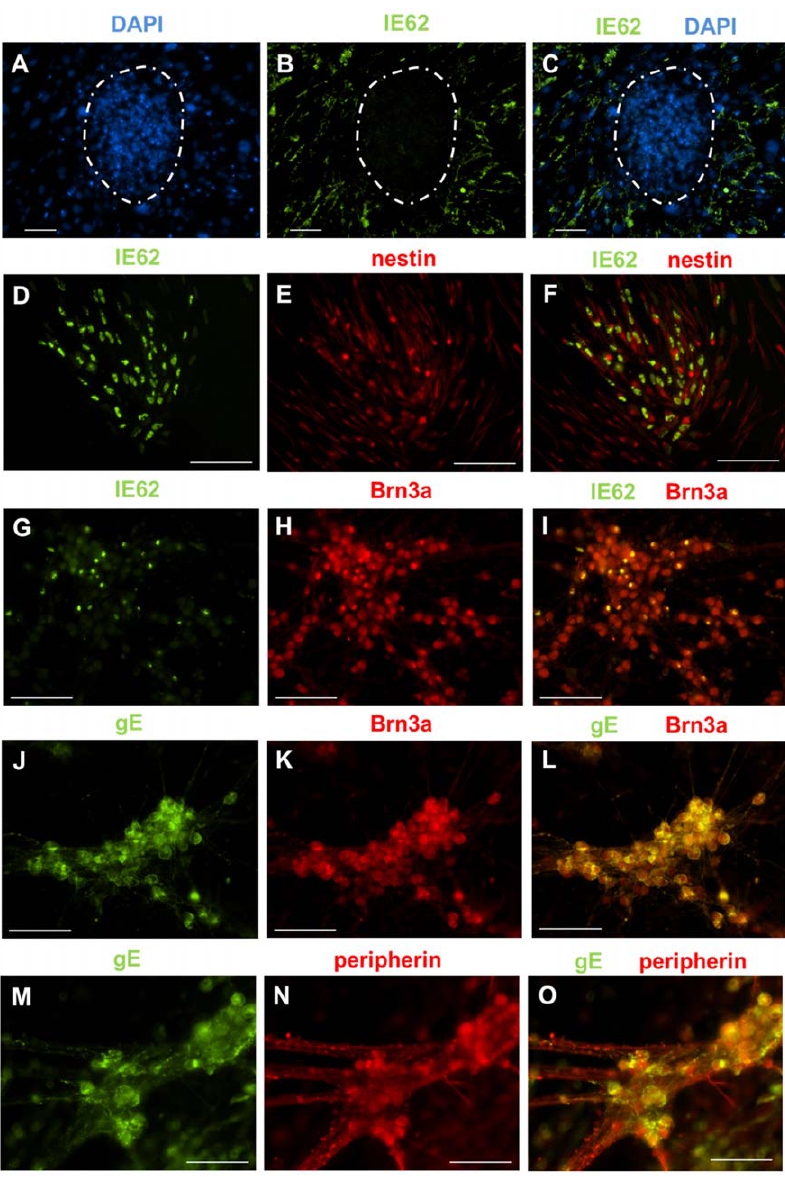
Figure 5. VZV infects iPS cell-derived neural progenitor cells and sensory neurons, but not undifferentiated iPS cells. (A–C) Undifferentiated iPS cell cultures were infected with cell-free VZV at a MOI of 0.1 for 96 hours. iPS cells grow as colonies (dotted white circles) on a monolayer of non-dividing fibroblasts. (A) DAPI staining identifies the iPS cell colonies. (B) Immunostaining for IE62 revealed that only the monolayer of fibroblasts supported VZV infection. No IE62 staining could be observed in the iPS cell colonies. (C) Merge of panels A and B. (D–F) Neural progenitor cells infected with cell-free VZV at a MOI of 0.1 for 96 hours. Staining for (D) IE62 and (E) nestin. (F) Co-expression of IE62 and nestin indicated that neural progenitors cells can be infected by VZV (merge of panels D and E ). (G–O) Differentiated iPS cell cultures containing sensory neurons were infected with cell-free VZV at a MOI of 0.1 for 96 hours. Immunostaining for Brn3a (H, K), peripherin (N), IE62 (G) and gE (J, M) revealed that Brn3a + cells co-expressed IE62 (I) and gE (L). Peripherin + cells also co-expressed gE (O) and IE62 (data not shown). Collectively, these data show that sensory neurons can be infected by VZV. Scale for all images is 100 um.